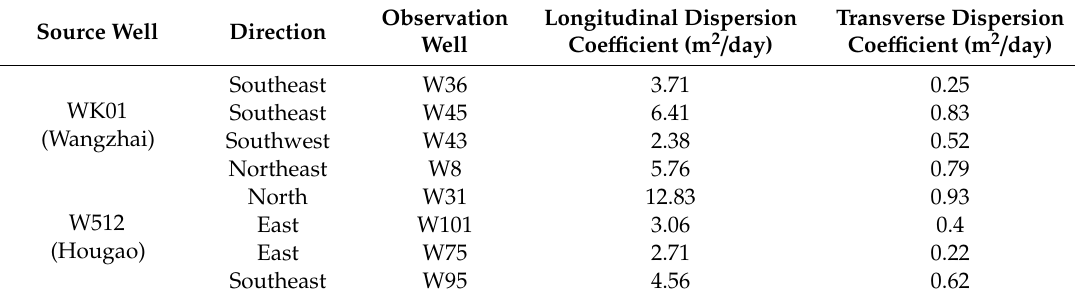
Table 2. Calculation results of the dispersion coe ffi